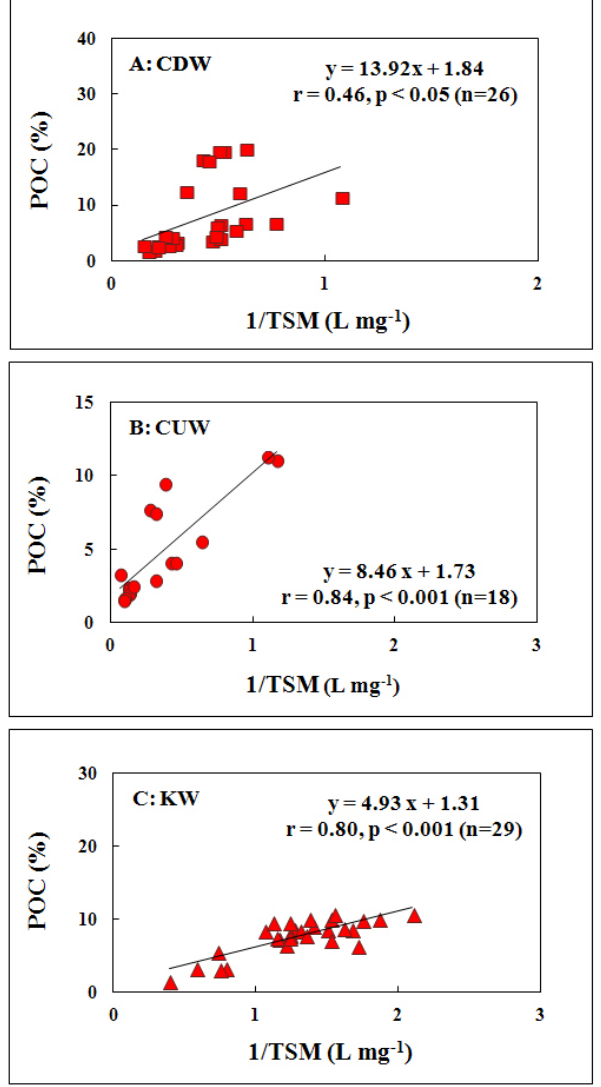
Fig. 5. (A) Relationships between POC (%) and 1/TSM in the CDW of the ECS. (B) Relationship between POC (%) and 1/TSM in the CUW of the ECS. (C) Relationship between POC (%) and 1/TSM in the KW of the ECS.